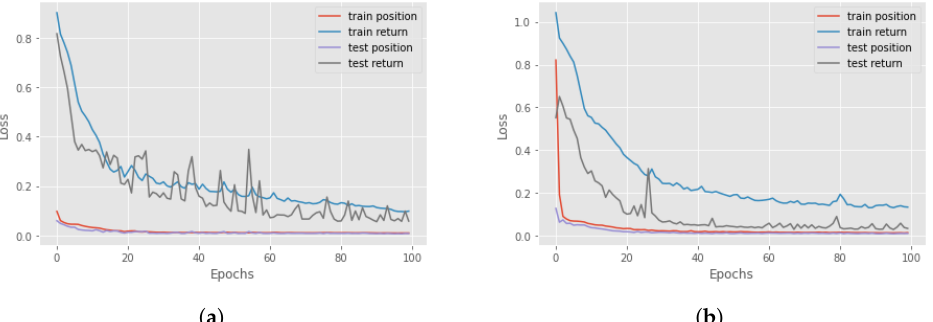
Figure 15. Results of the training and test of the RNNs for the distal prediction in the Mountaincar en- vironment. ( a ) Loss of the RNN for the distal direct prediction. ( b ) Loss of the RNN for the distal counterfactual